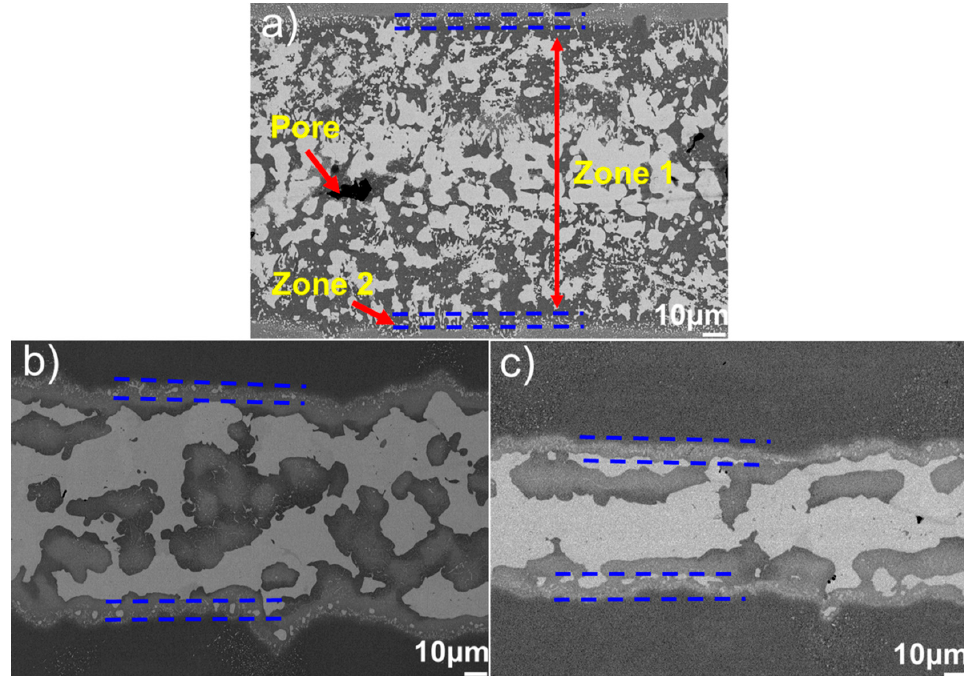
Figure 3. SEM back-scattered electron micrographs of the DD98M/Pd-Si/DD98M joints brazed at different temperatures for 30 min: ( a ) 1020 ° C, ( b ) 1060 ° C, and ( c ) 1100 ° C. di ff erent temperatures for 30 min: ( a ) 1020 ◦ C, ( b ) 1060 ◦ C, and ( c ) 1100 ◦